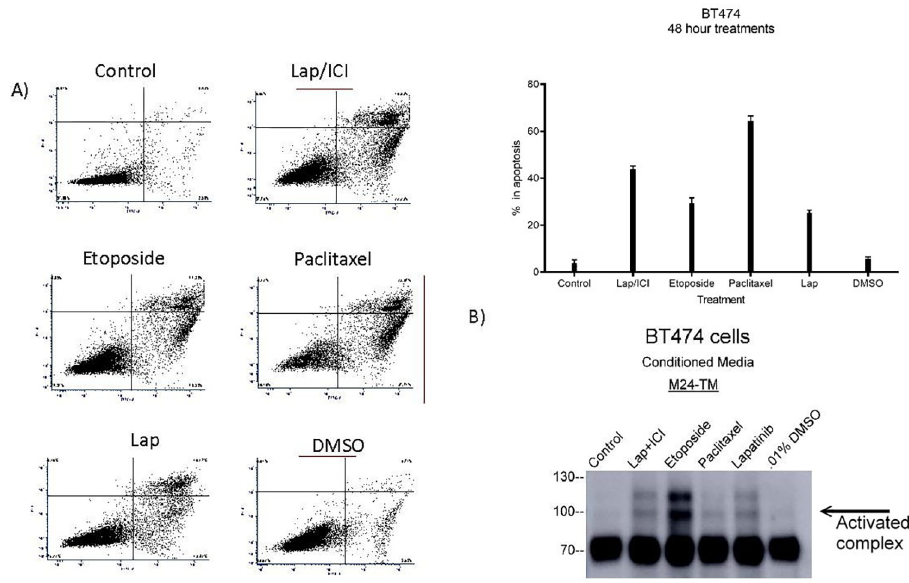
Fig 4. Comparing methods of cellular stress showed that matriptase activation was not a hallmark of cellular stress but was robustly induced by etoposide. 100,000 BT474 cells/well were seeded into wells of a 6-well plate and allowed to attach overnight. Cells were then treated with 5.4uM Lapatinib and 1uM ICI in combination, 10uM Etoposide, 1uM Paclitaxel, 5.4uM Lapatinib alone, or 0.01% DMSO in either serum-replete or serum-free parallel experiments. Panels are representative of three biological replicates. Cells treated in serum-replete conditions were collected and A) assayed for apoptosis by Annexin V/Propidium Iodide staining and the conditioned media from cells treated in serum-free conditions was collected in order to B) determine levels of total and activated matriptase by immunoblotting with the total matriptase (M24) monoclonal antibody. Panels were the highest quality representative of 4 biological